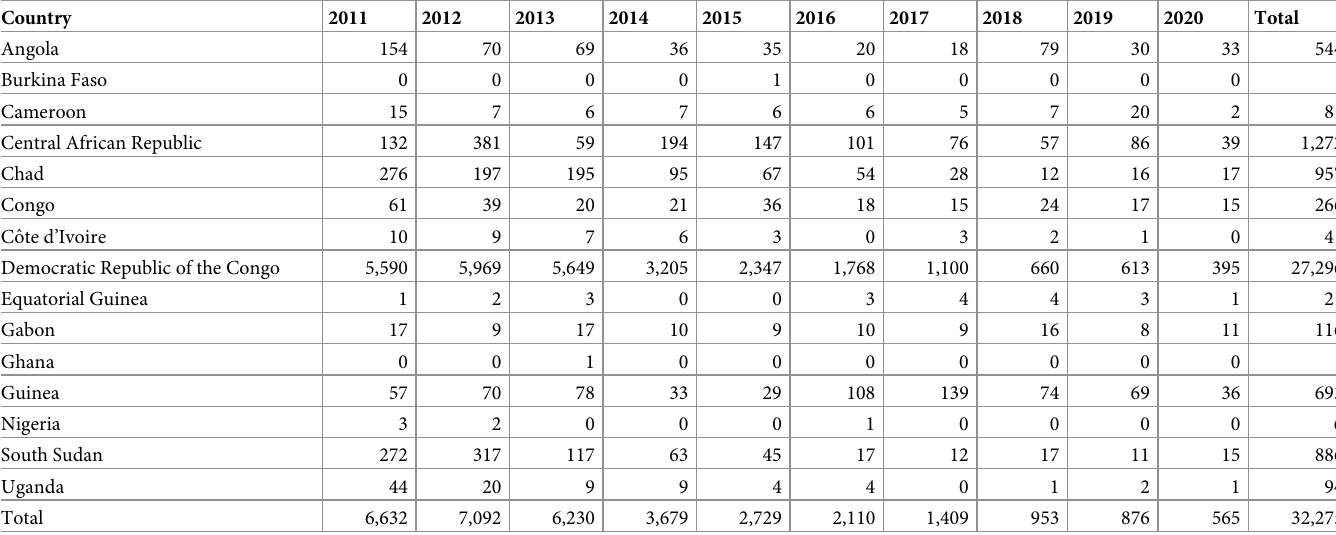
Table 1. T . b . gambiense HAT: new cases reported between 2011 and 2020. Country